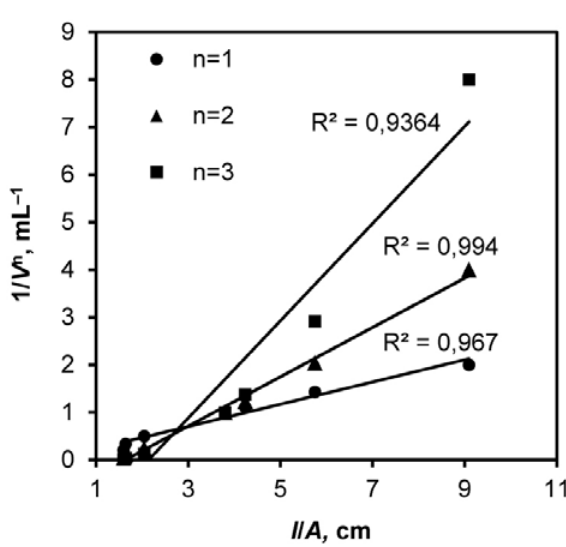
Figure 3 . Determination of the molar ratio (n) Ge(IV):Nt by the method of Asmus.